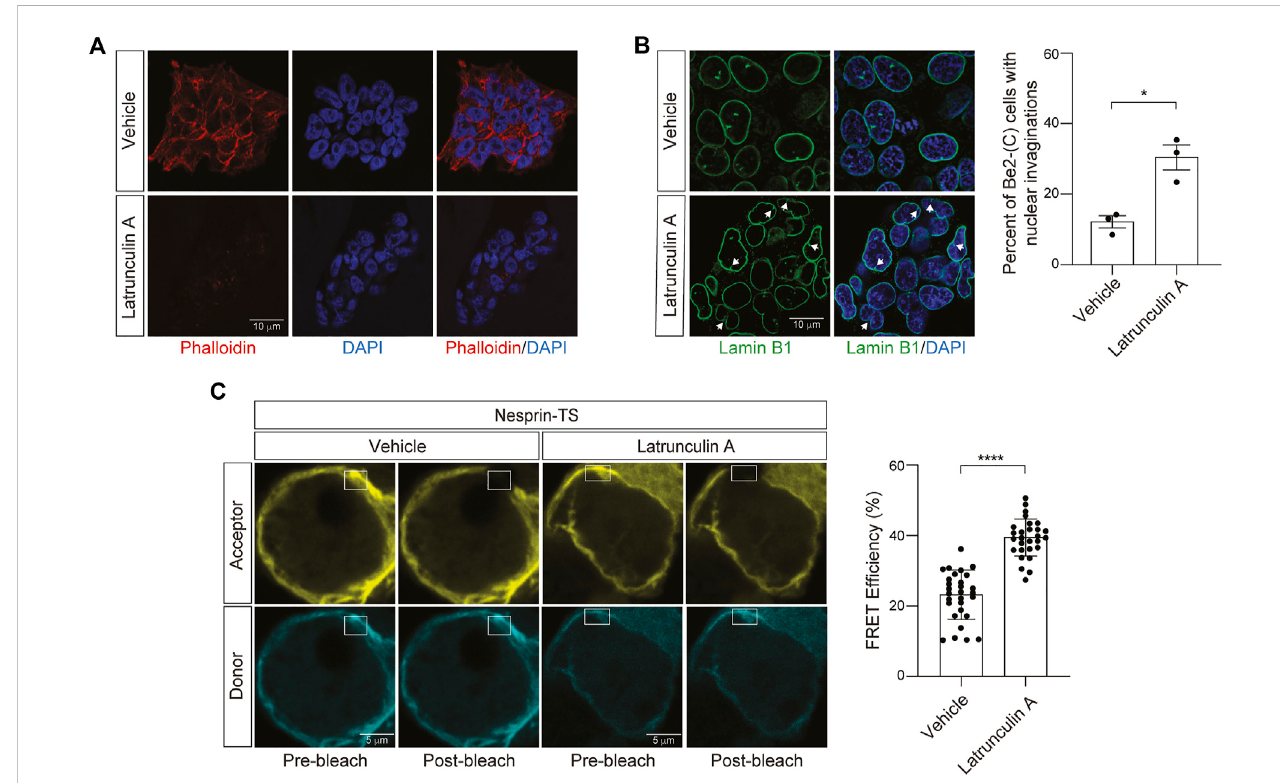
FIGURE 4 Latrunculin A-induced depletion of F-actin reduces nuclear tension in neuroblastoma cells. (A) Phalloidin-based visualization of F-actin in BE(2)-C cells treated with 10 µM latrunculin A or vehicle (DMSO) for 15 min. (B) Latrunculin A treatment drives an increase in nuclear envelope invaginations detected by lamin B1 immuno fl uorescence. n = 3 replicates per group, t -test, * p < 0.05. (C) Acceptor photobleach-based quanti fi cation of FRET in nesprin-TS expressing BE(2)-C cells upon treatment with 10 µM latrunculin A compared to vehicle. Each datapoint represents FRET analyzed in a single nucleus. Thirty nuclei were analyzed across three different wells (10 nuclei/well), t -test, **** p < 0.0001. Error bars indicate